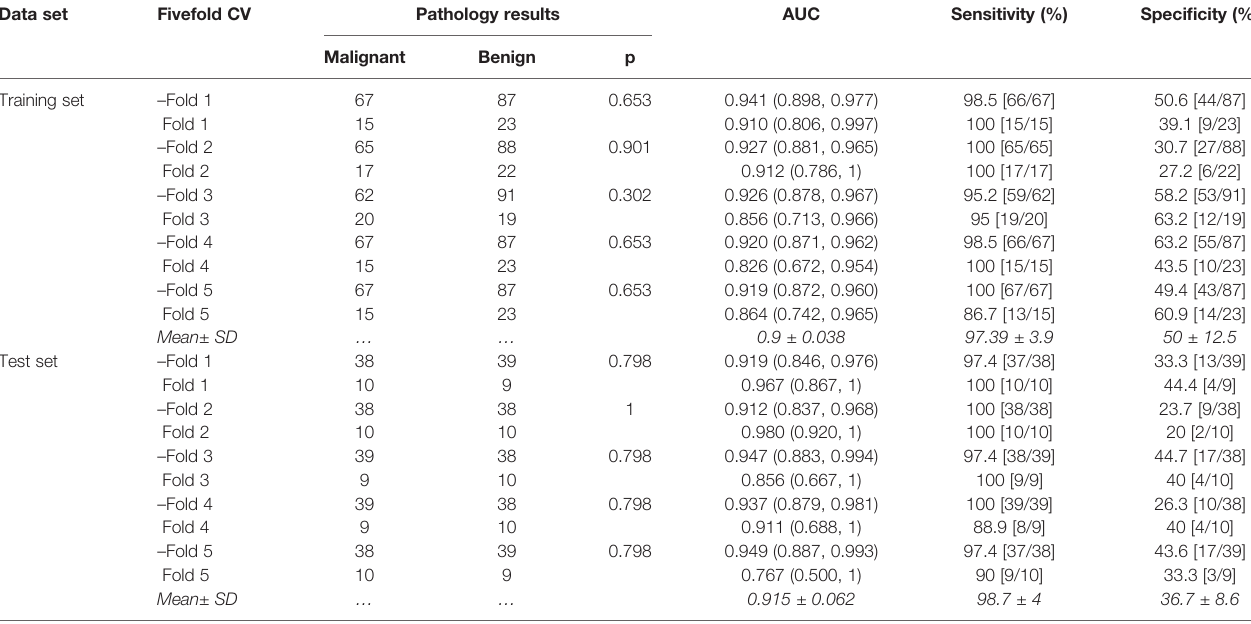
TABLE 4 | Classi fi cation performance of radiomics model in fi vefold